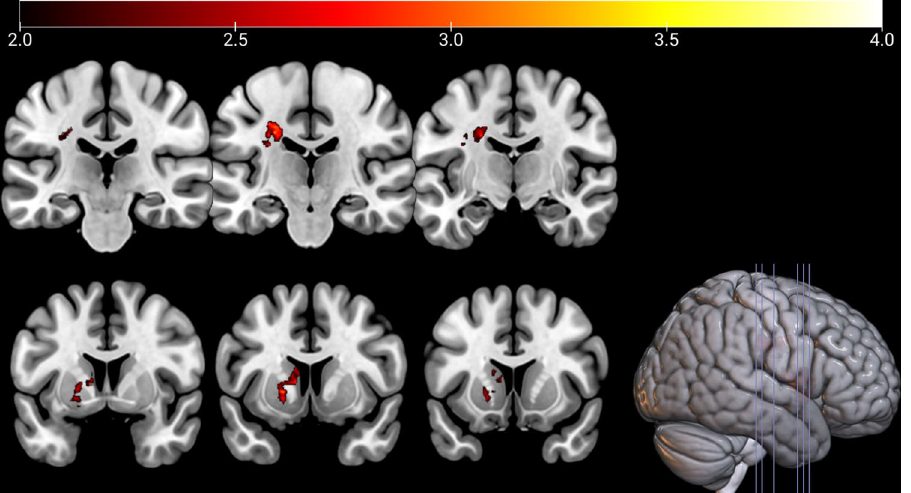
Figure 5. Non-parametric voxel-wise comparison maps. Two non-parametric samples with adjustment for the confounders of age and sex. The colour bar represents the p-value of nonparametric tests for voxel-wise comparison maps from the patients in the CRPS and control groups. CRPS patients showed significant damage in the corticospinal tract of the white matter (local maxima, uncorrected p = 0.0002), caudate nucleus, and putamen (local maxima, uncorrected p = 0.0006). The colour bar represents t